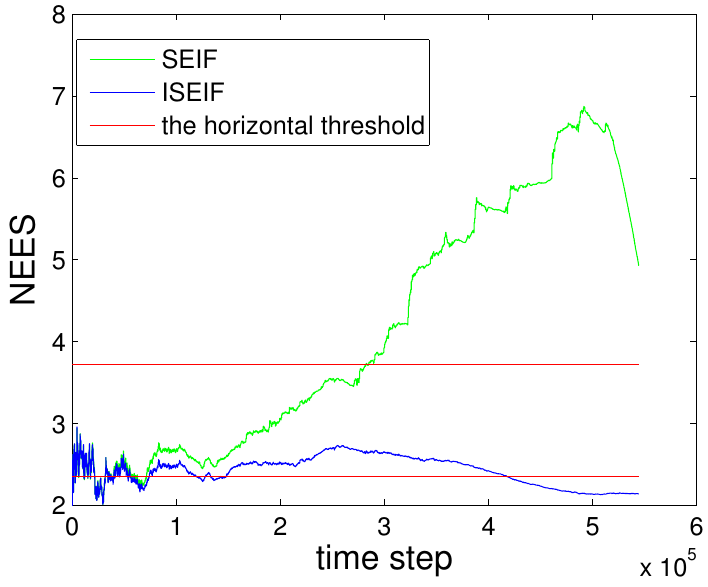
Figure 9. Plots of the NEES of both SEIF and ISEIF for the Victoria Park dataset.